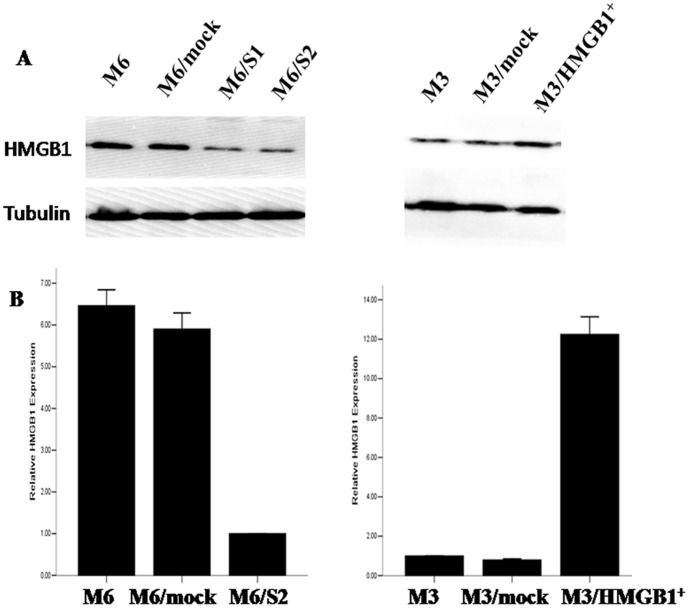
HMGB1 expression in interfered HCC cells.(A)Western blot was performed to determine HMGB1 protein expression in HCCLM6, HCCLM6/mock, HCCLM6/S1, HCCLM6/S2, HCCLM3,HCCLM3/mock,HCCLM3/HMGB1+); Tubulin was used as a control. (B)qRT-PCR was performed to determined HMGB1 mRNA expresion in HCCLM6, HCCLM6/mock, HCCLM6/S2, HCCLM3, HCCLM3/mock, HCCLM3/HMGB1+).